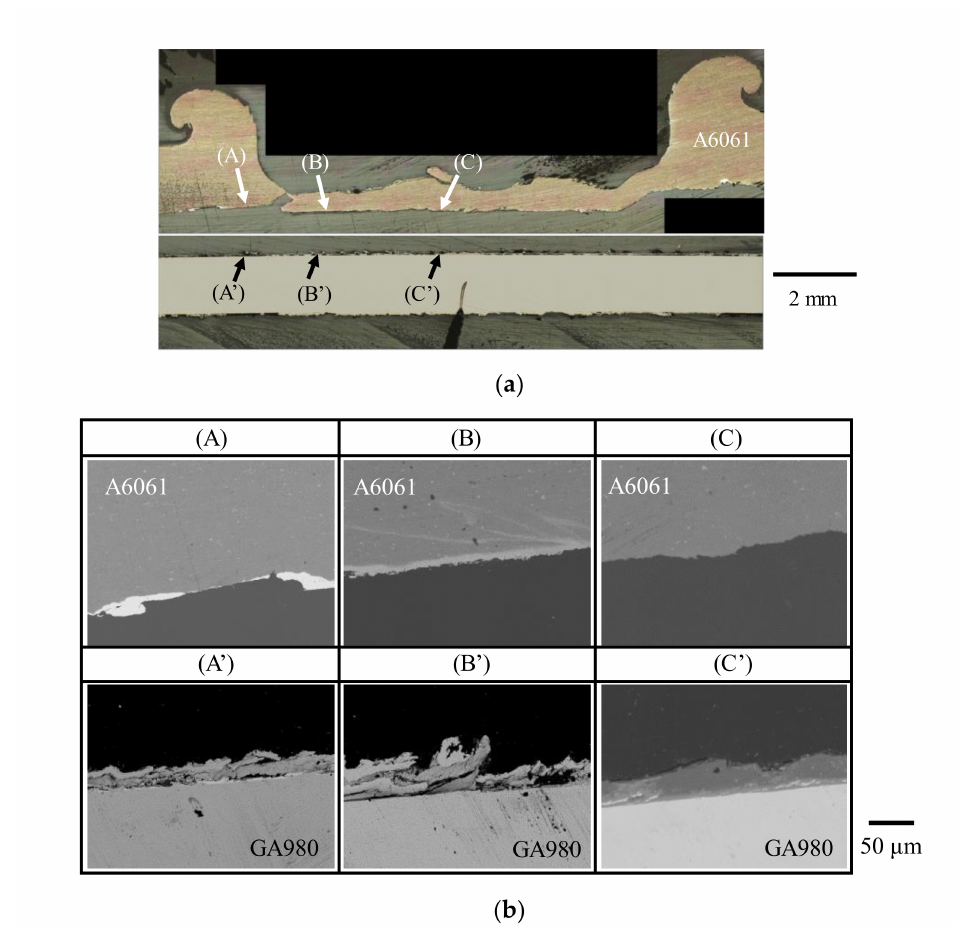
Figure 11. Cross-sectional image of the specimen ruptured by interfacial fracture in the tensile shear test (welding time: 10 s, specimen No.: No. 1). ( a ) General view from optical microscope imaging and the analyzed area using EPMA and ( b ) BSE images of the areas shown in Figure 11a observed with